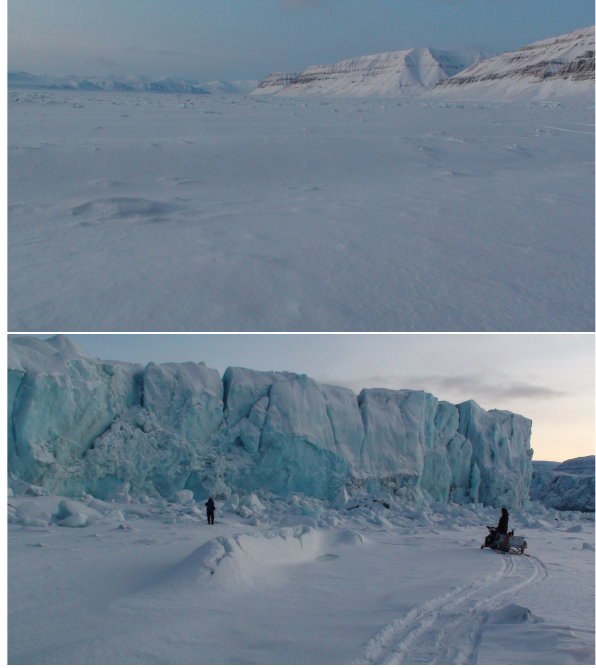
Fig. 2. Deformed sea ice near the glacier front: buckling (above) and fold (below).